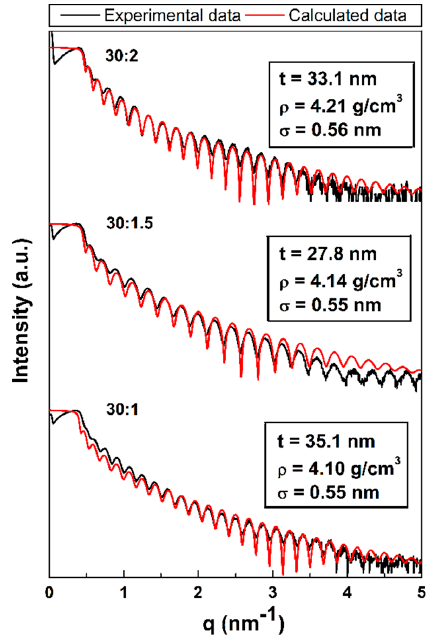
Figure 4. XRR profiles and calculated data. Inset represents thickness (t), density ( ρ ) and surface roughness ( σ ).